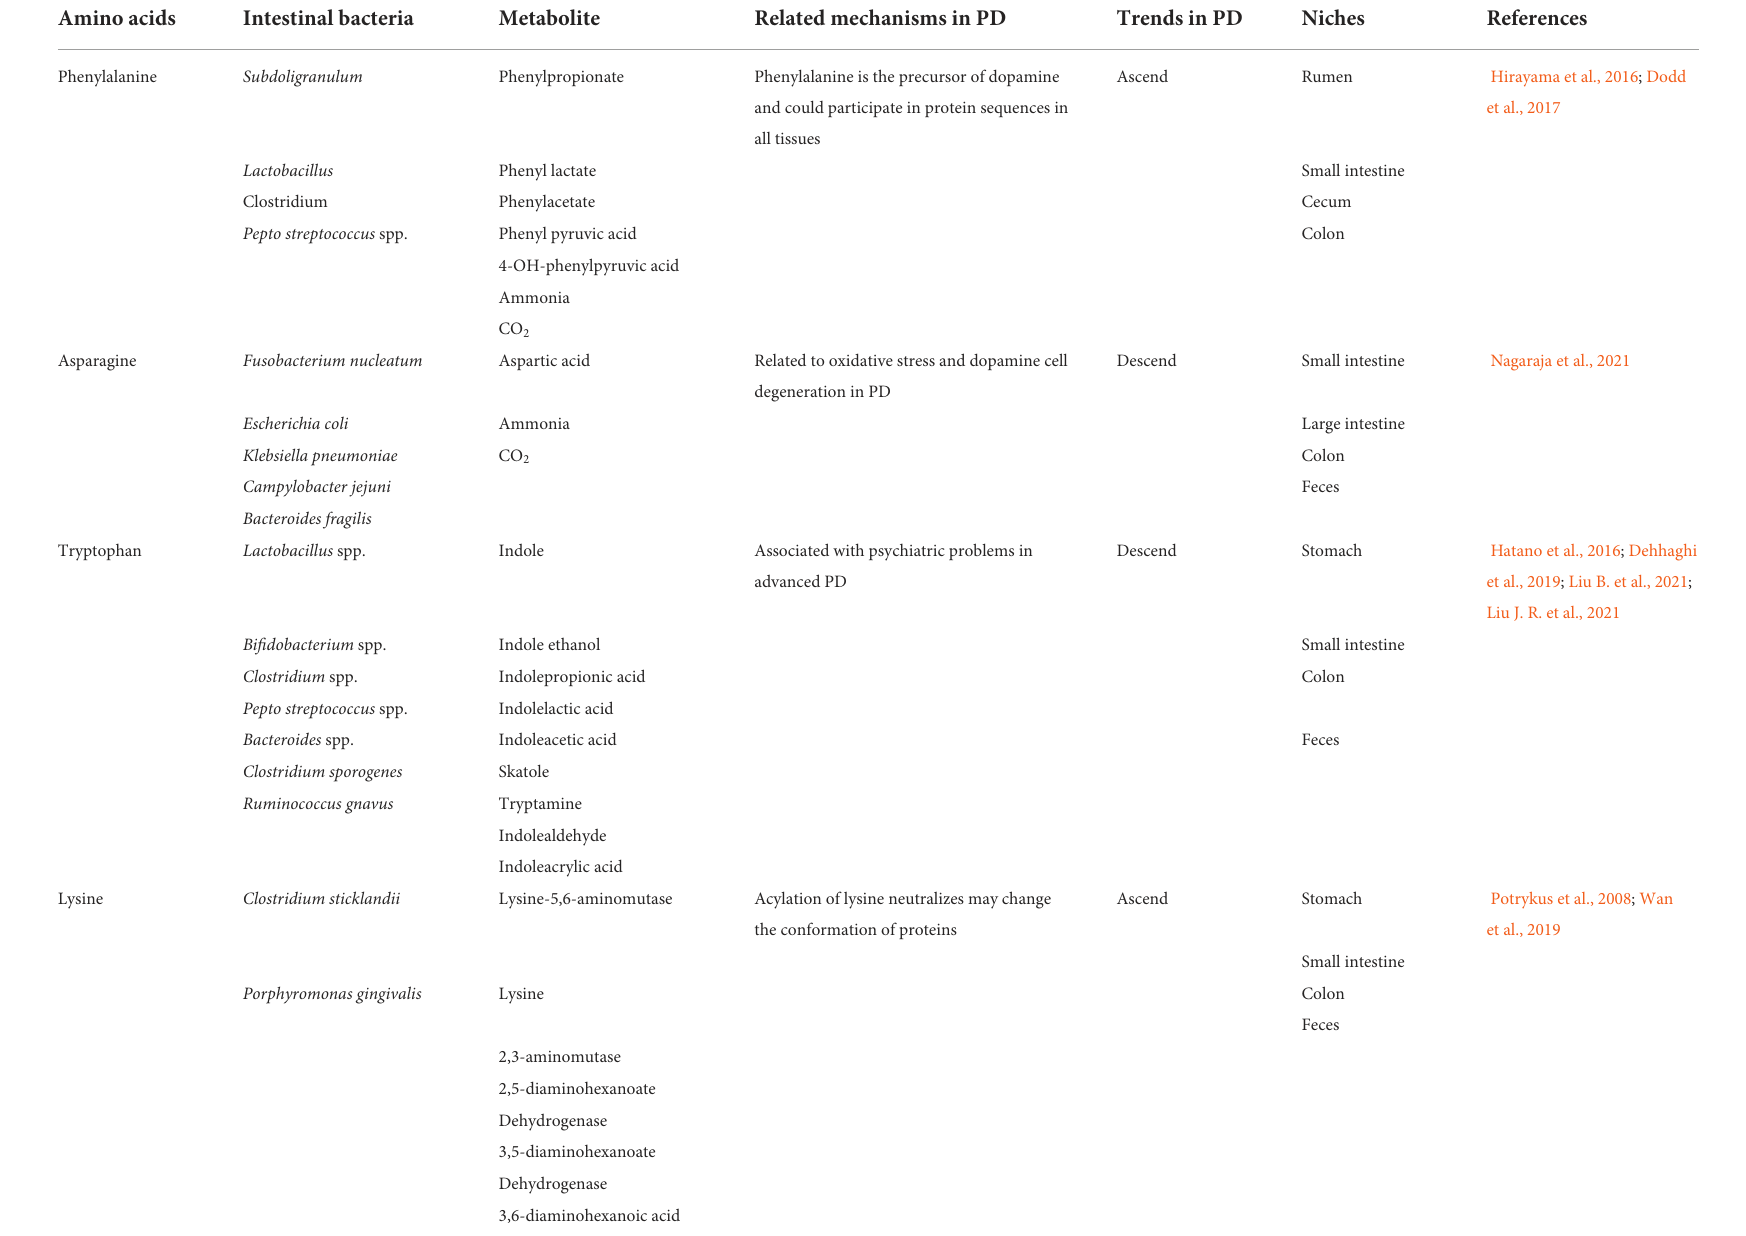
TABLE 2 Major amino acid-fermenting bacteria in the digestive